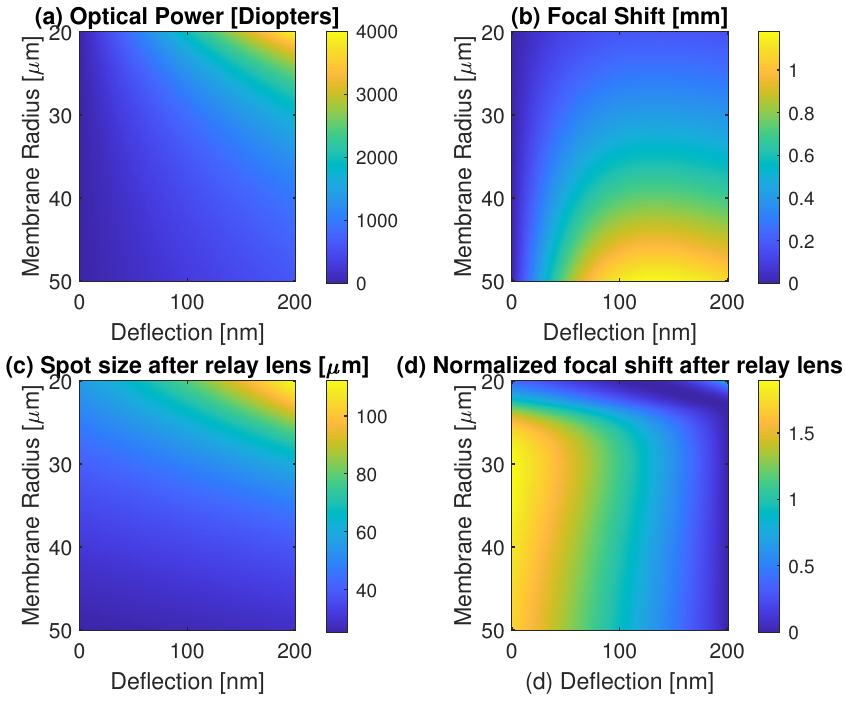
Figure 2. Simulations when the laser is focused onto the CMOF membrane and the Gaussian beam waist is 0.4 of the membrane radius. ( a ) Optical power of a CMOF for various membrane sizes and deflection; ( b ) focal length shift of a laser beam after refocusing with a CMOF for various membrane sizes and deflections; ( c ) focal spot size change of a laser beam after refocusing with a relay lens with a 3 mm focal length; ( d ) focal spot shift of a laser beam after a 3 mm focal length relay lens as normalized by the minimum Rayleigh range of the refocused beam after the relay. In ( c , d ), the relay lens is positioned 3.2 mm away from the CMOF